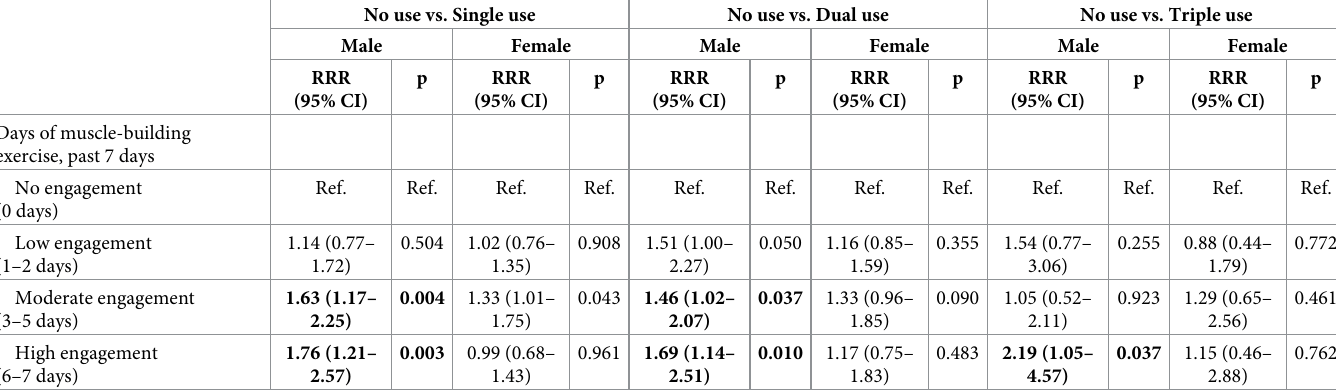
Table 3. Associations between muscle-building exercise and concurrent substance use among male and female participants from the 2019 Youth Risk Behavior Sur- vey (N =